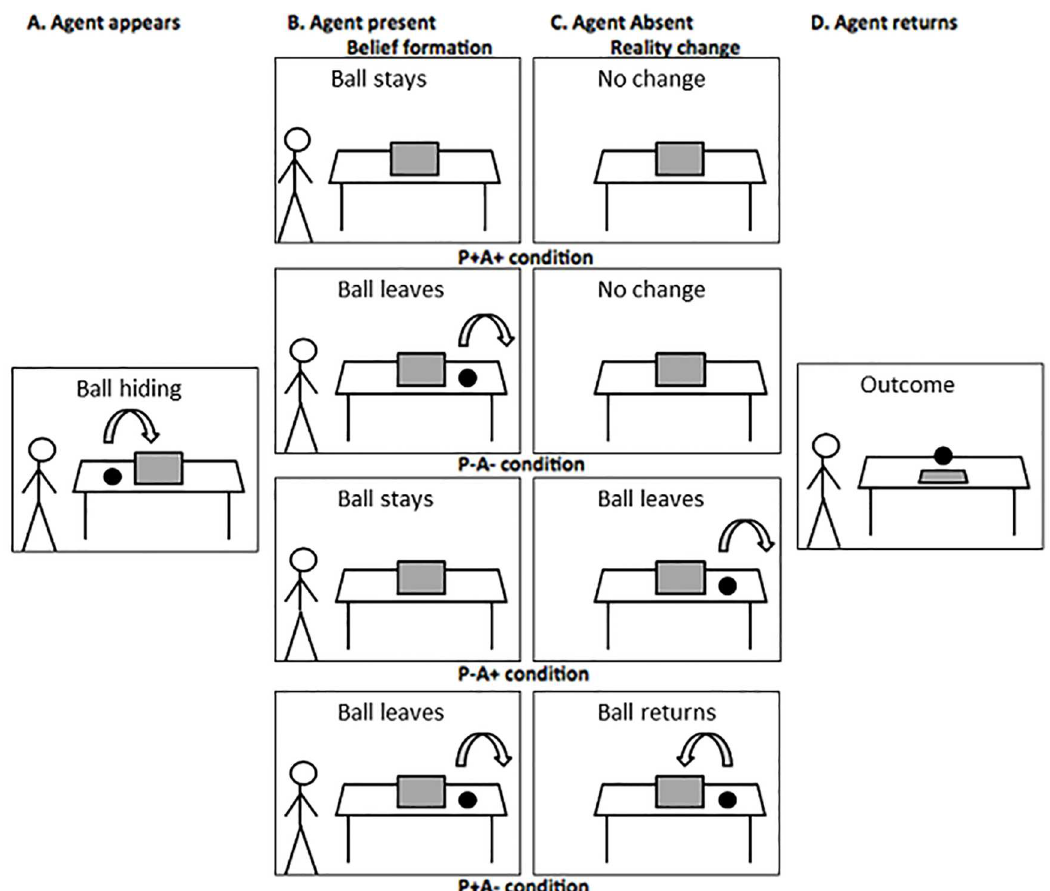
Fig 1. Schematic illustration of the eight conditions, resulting from four different options in the Belief Formation phase (B and C), and two options in the Outcome phase (D). In the first part of the movie (A), the ball rolls behindthe screen. In the second part (B), Buzz is present and the ball sometimes changes location. In the third part (C), Buzz is absent and the ball sometimes changes location. In the last part (D), the occluder falls and the ball is present or not. Note: these are not the originalstimuli, as these could not be printed due to copyright